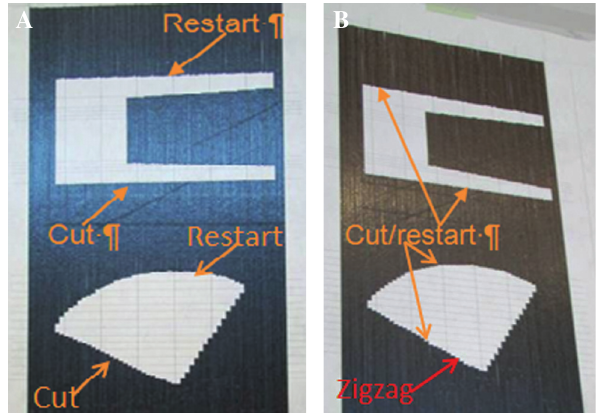
Figure 16 Cut/restart trial: 6 m/min, (A) one-directional; (B) bi-directional.